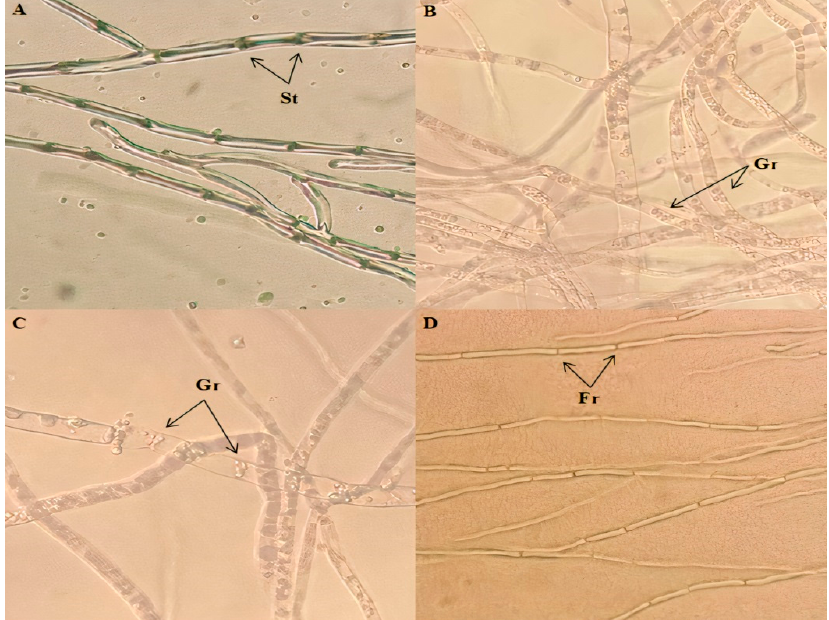
Figure 1. Light microscopy observations of the impact of selected Pseudomonas strains on Foc-S1 hyphae morphology (40×). ( A ) Control; ( B ) Effect of E1PP7; ( C ) Effect of E1FP4; ( D ) Effect of E1FP13. (St) Septa; (Gr) Granulations; (Fr) Fragmentations.